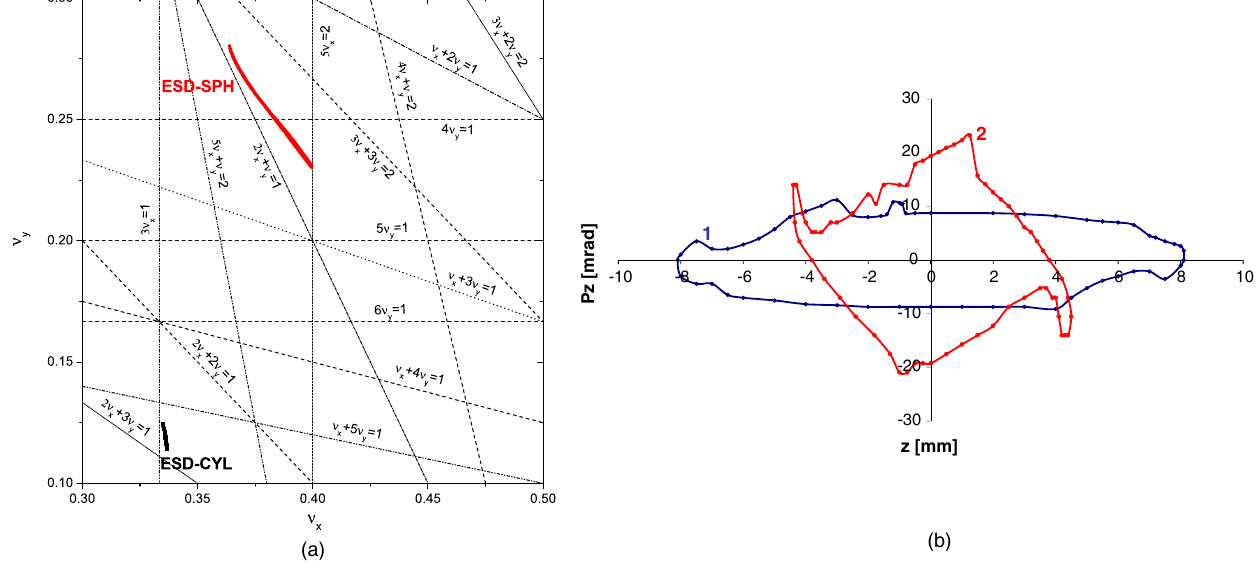
FIG. 3. Parameters of the ELISA ring: (a) amplitude dependent tune shift in the ring with deflectors of spherical (red) and cylindrical (black) shape, simulated by MAD-X [23]; (b) vertical acceptance of the ELISA ring. Stable orbits have been tracked in relaxation electric field mesh generated by OPERA-3D / TOSCA3D . The middle of the long straight section is marked as (1) and the middle of the 160 (cid:2) cylinder deflector as (2). The ring acceptance in vertical phase space is less than 30 (cid:4) mm mrad [22].